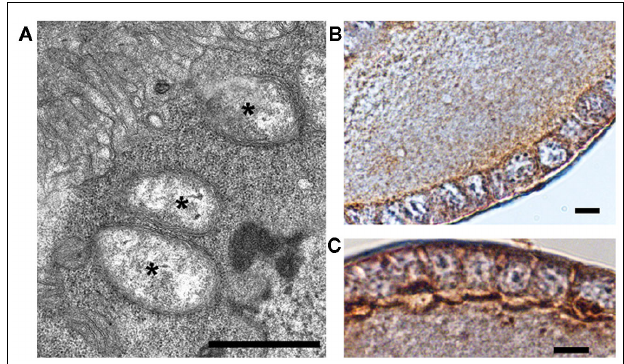
FIGURE 1 | Wolbachia ’s localization in the host’s follicular epithelium of the gonad. (A) TEM micrograph of a Wolbachia -infected Zyginidia pullula (Hemiptera, Cicadellidae) follicle cell filled with bacteria (asterisks; bar = 0.9 μ m); (B,C) Immuno-histochemical reactions showing strong positivity (brown) to anti- wsp ( Wolbachia surface protein) antibody in the leafhopper’s follicular epithelium (bars = 10 μ m). Modified from Negri and Pellecchia (in